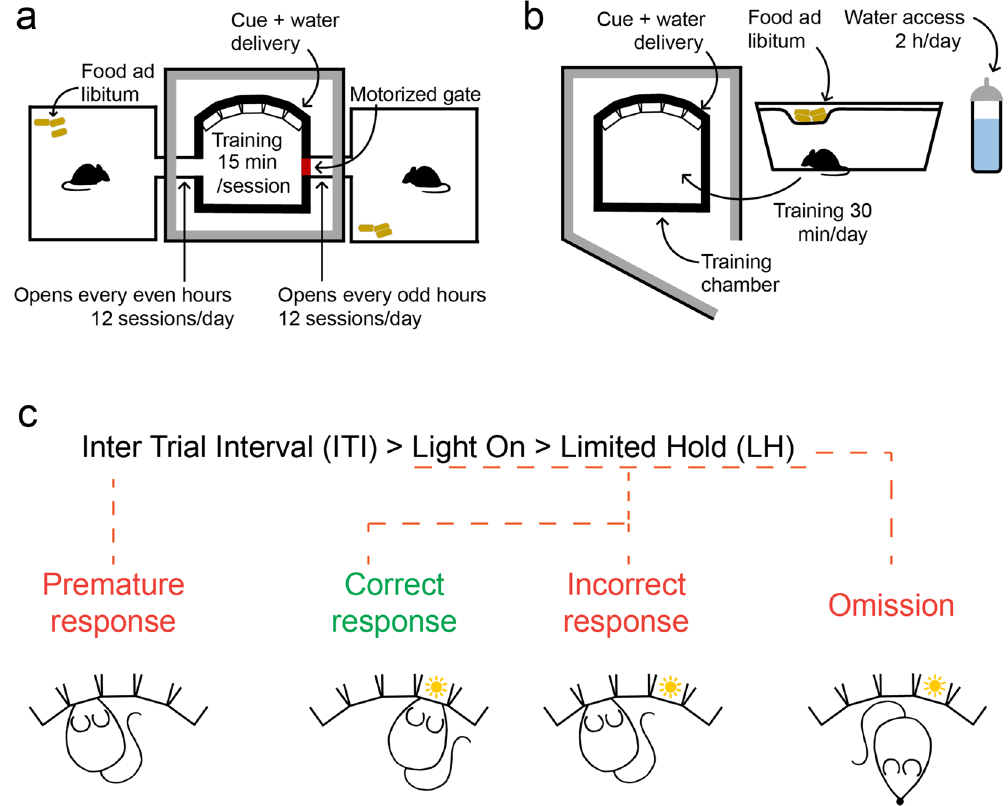
Figure 2. Training protocol ( a ) Schematics of ATS training. All animals had access to food ad libitum in their home cages, whereas they received water in the training chamber, accessible for 15 min in every two hours (free access to water at the beginning of each session and water rewards during training). ( b ) Schematics of manual training. Animals were kept in standard mouse cages with access to food ad libitum . Water was freely available for two hours/day. Mice were moved to the training chamber for 30-min training sessions daily, where they received additional water as reward, then moved back to their home cages. ( c ) Trial phases and possible outcomes of the 5-choice serial reaction time task.